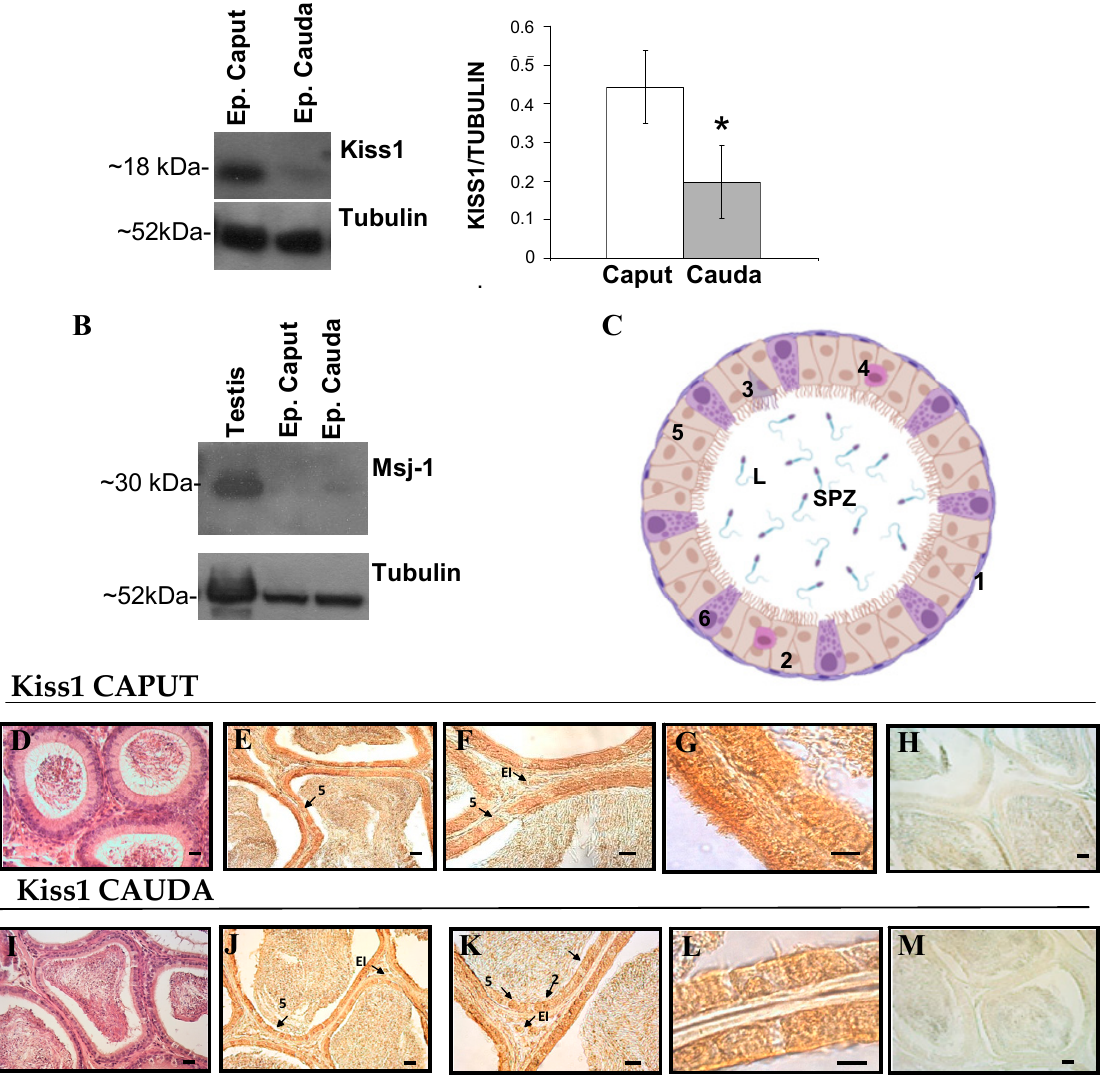
Figure 5. Expression and localization of Kiss1 in rat epididymis. ( A ) Western blot for Kiss1 in spermatozoa free epididymis caput and cauda. ( B ) Western blot for MSJ-1, used as a specific marker of spermatozoa. ( C ) Schematic representation of cell types in epididymal epithelium, with Kiss1 immunoreactive cells in beige. 1: Myoid cells; 2: basal cells; 3: apical cells, 4: Halo cell, 5: principal cells, 6: clear cells, L: lumen, SPZ: spermatozoa. ( D–H ) Histological sections of caput ep-